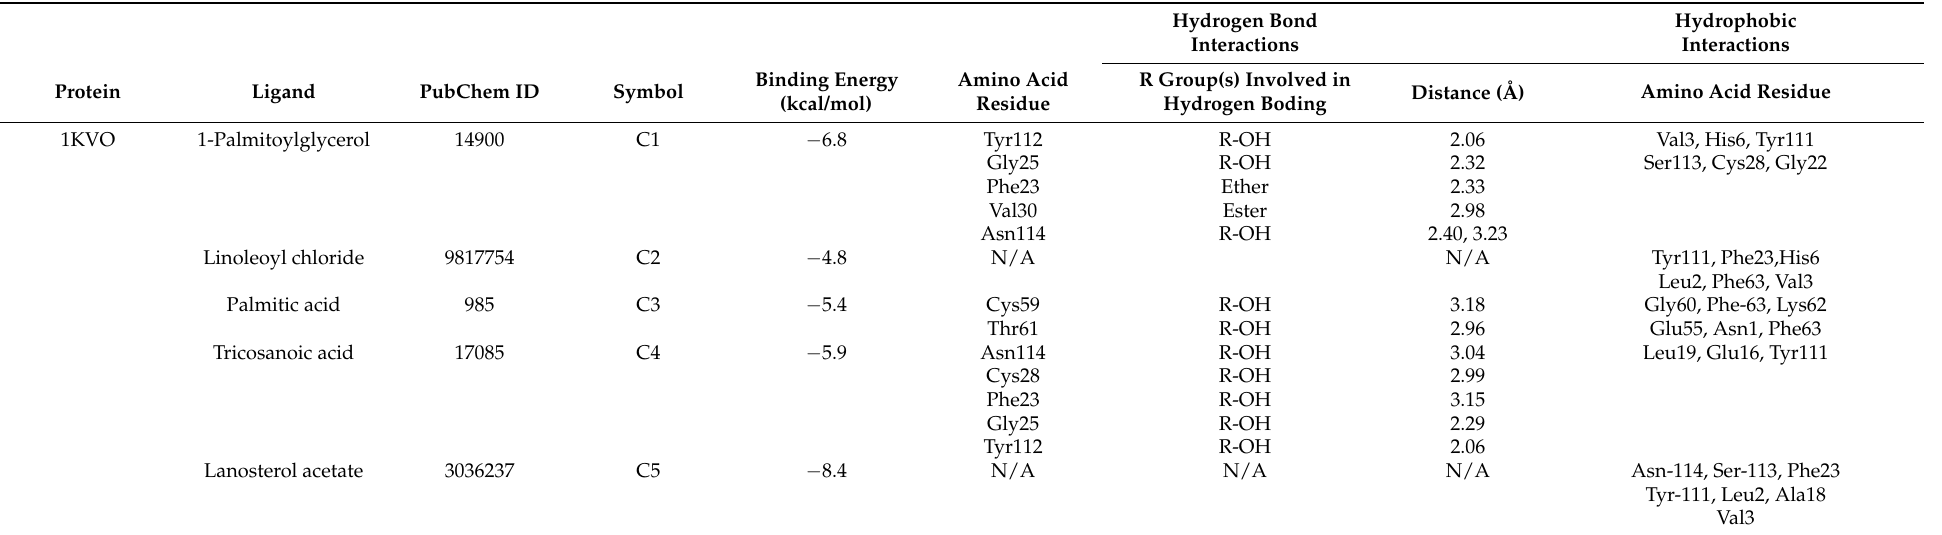
Table 7. Binding energy and interactions of potential bioactives on PLA2G2A (PDB ID: